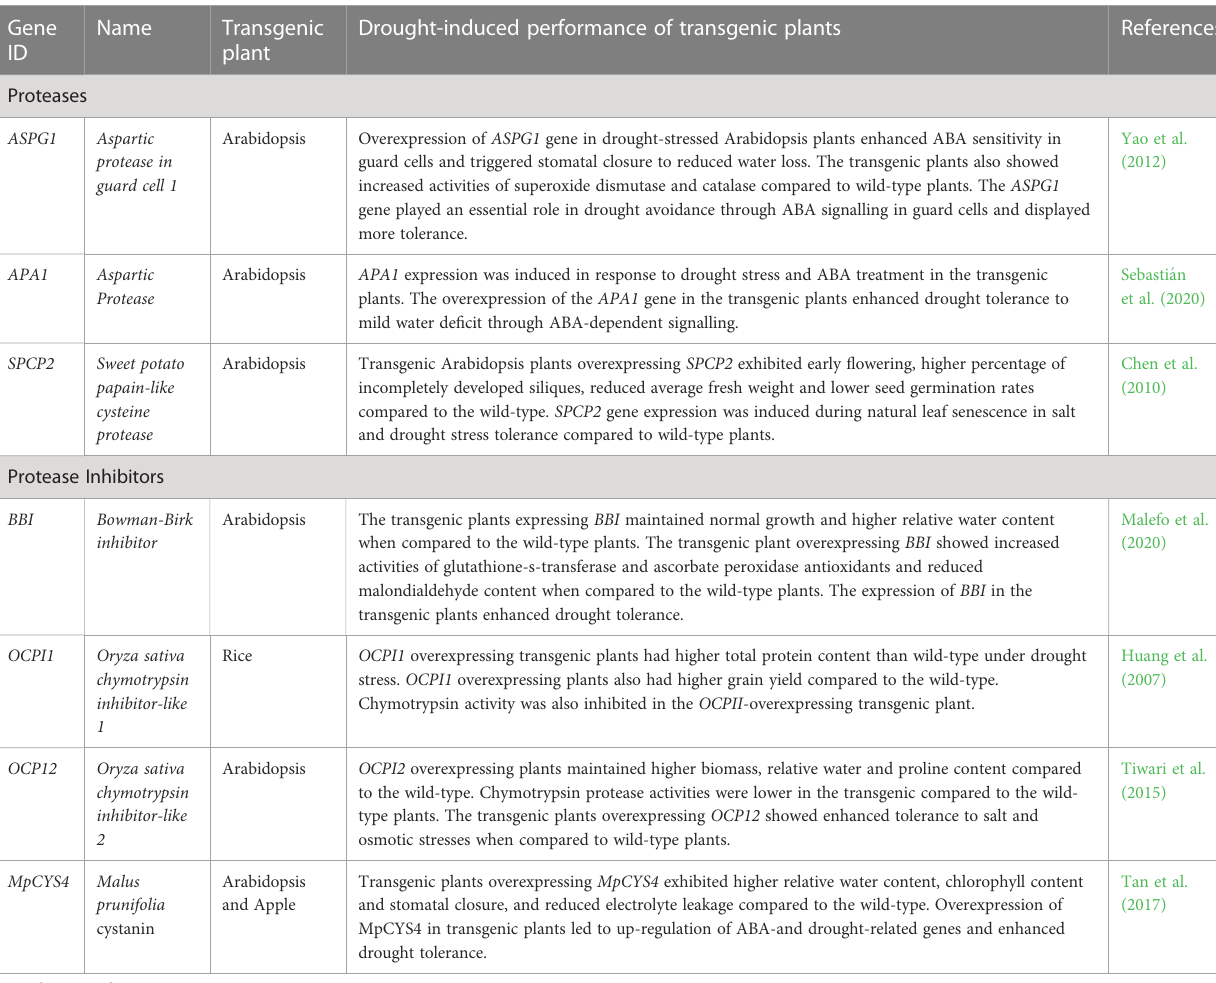
TABLE 5 List of transgenic overexpression studies illustrating the roles of protease and protease inhibitors in plants under drought